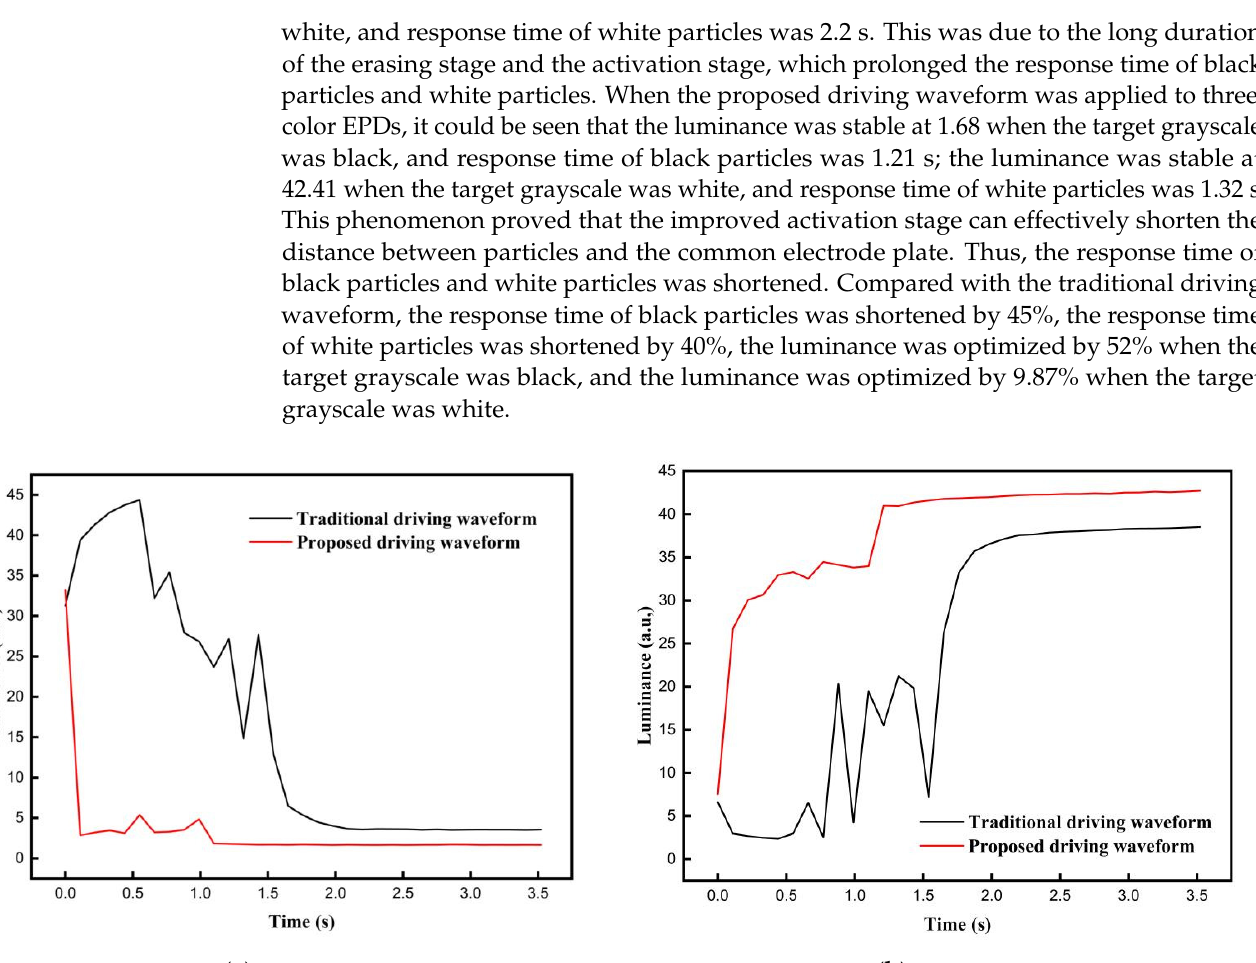
Figure 9. Luminance linear comparison of response time between the traditional driving waveform and the proposed driving waveform. ( a ) The relationship between luminance and response time when the target grayscale was black. ( b ) The relationship between luminance and response time when the target grayscale was white.